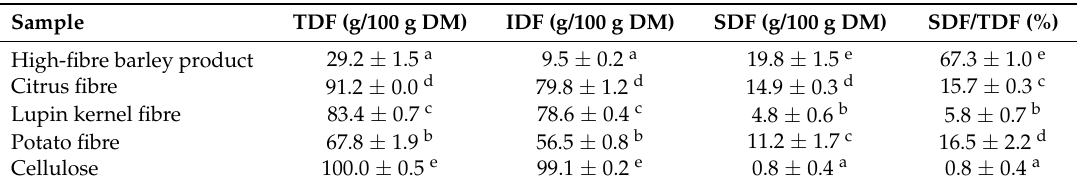
Table 1. Dietary fibre composition of dietary fibre-rich materials and the reference cellulose (soluble dietary fibre (SDF), insoluble dietary fibre (IDF), total dietary fibre (TDF), n = 3).